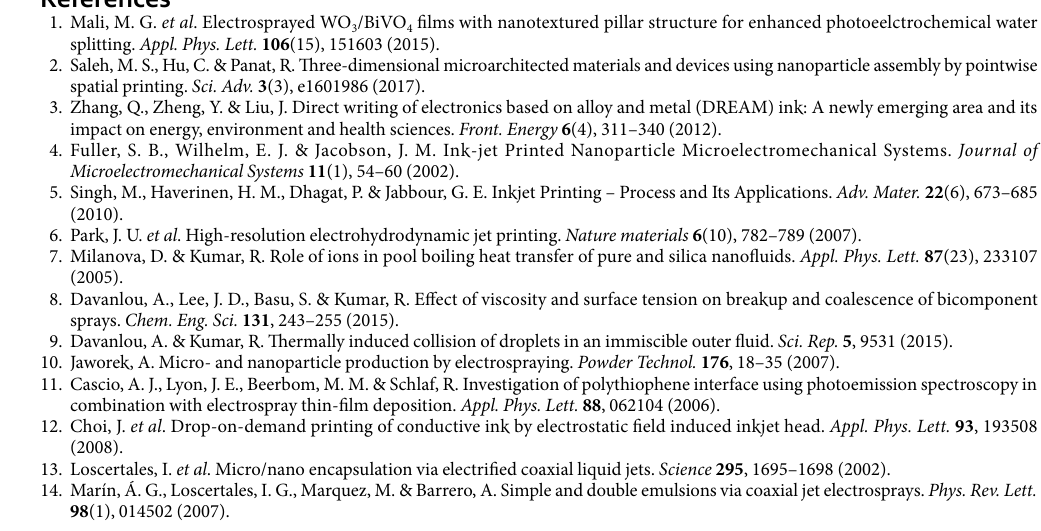
9 Scientific RepoRts | 7: 5144 | DOI:10.1038/s41598-017-05175-6